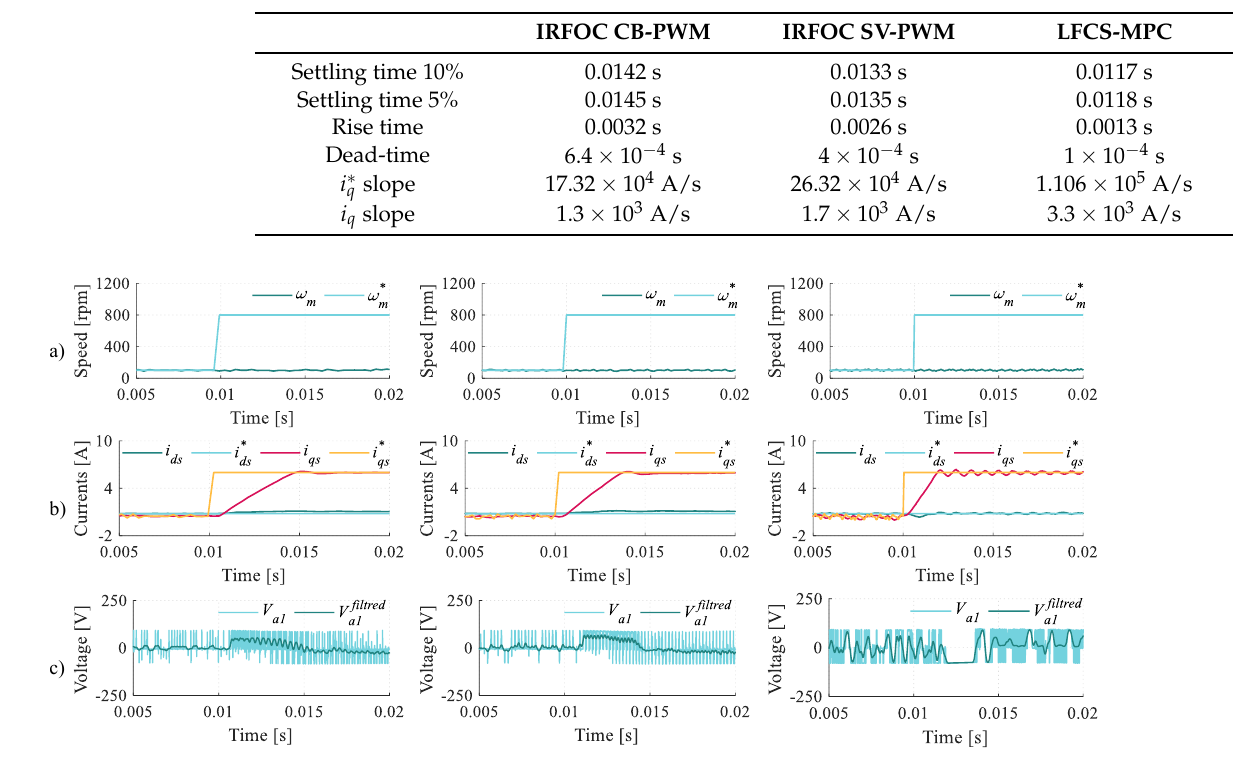
Figure 8. Test 1. Speed-step response of IRFOC CB-PWM ( left ), IRFOC SV-PWM ( center ) and LFCS-MPC ( right ). From top to bottom: ( a ) Mechanical speed, ( b ) d − q currents and ( c ) voltage of the phase a 1